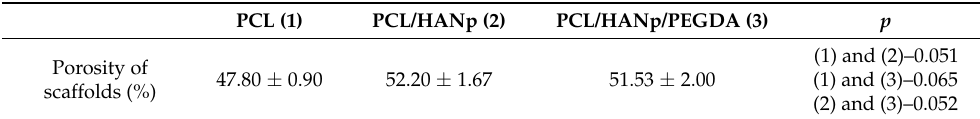
Figure 5. 3D micro-CT images (CTVox v.3.2.0 (Bruker Micro-CT)) of ( A ) PCL scaffolds, ( B ) PCL scaffolds with the addition of hydroxyapatite nanoparticles, and ( C ) PCL/HANp scaffolds submerged in PEGDA solution. Table 1. Porosity (CTAn v.1.20.3.0 software (Bruker Micro-CT)) of PCL, PCL/HANp and PCL/HANp/PEGDA scaffolds (mean ± standard deviation). Differences were considered statistically significant at p ≤ 0.05.